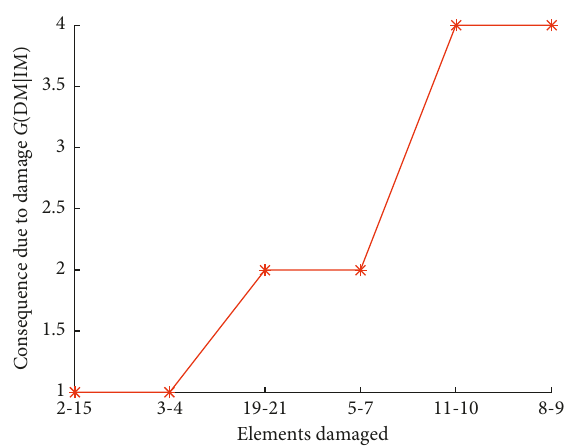
Figure 6: Geometry plot of consequence function for each